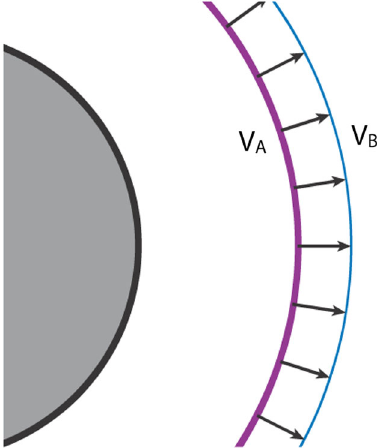
FIG. 6. Snapshot of perceptually enhanced representation depicting potential difference and electric field (see also Fig. 7). The difference in color and thickness between the two rings represents the potential difference between locations A and B (see also Fig. 7). The radiating black arrows represent the local electric field between the two rings.